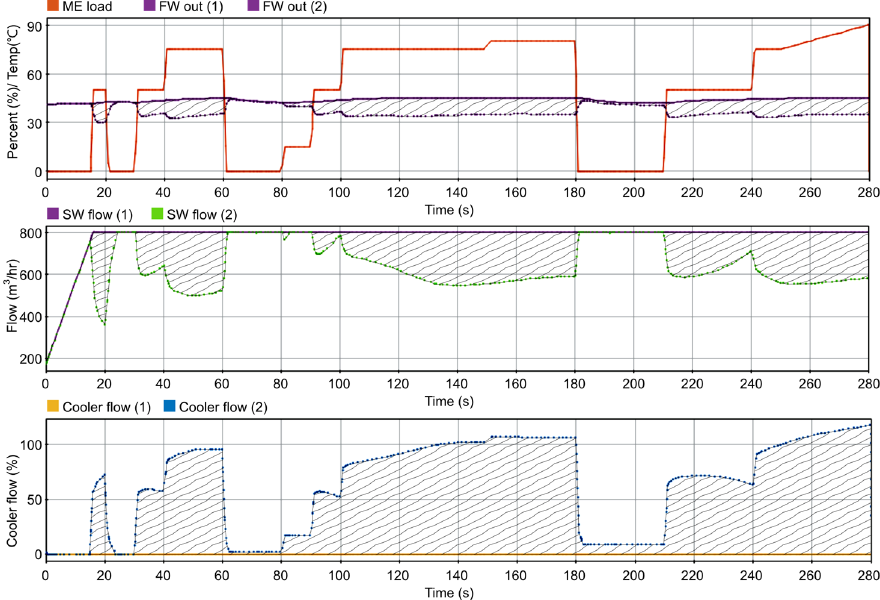
Figure 11. Experimental results of central cooling system with feed-forward controller.